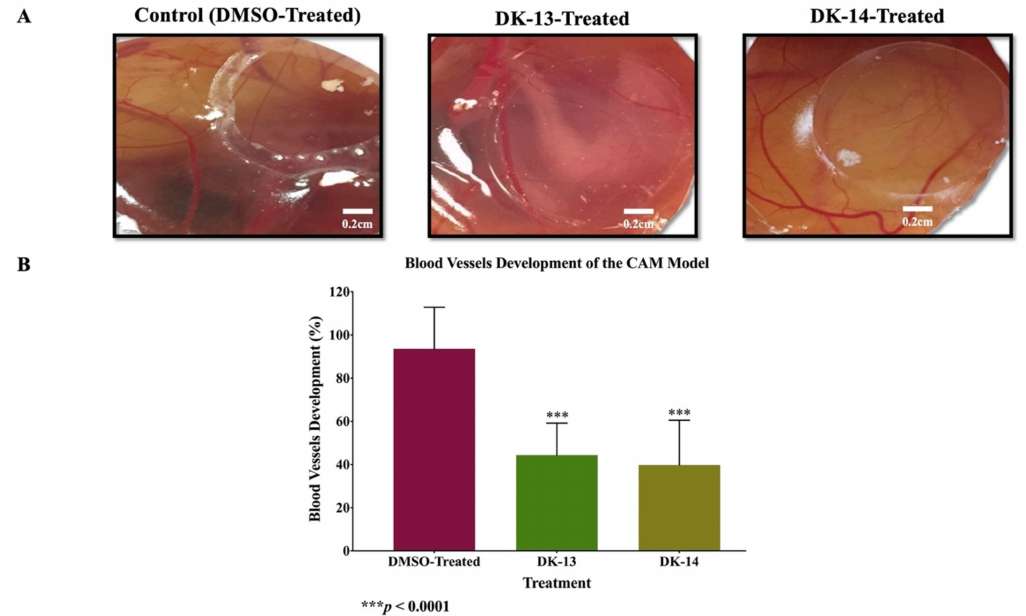
Figure 8. ( A , B ). The effect of DK-13 and -14 on angiogenesis of the CAM model 48 h after treatment. This analysis was performed using CAM treated with DMSO (control) and those exposed to chalcone compounds (DK-13 and DK-14). ( A ) The images on the top show the unexposed areas and those on the bottom show areas that were exposed to the treatment (under the coverslip) of the same embryo. ( B ) Two areas within each individual embryo in both groups were compared to examine total blood vessels’ development of controls vs. treated embryos (*** p <